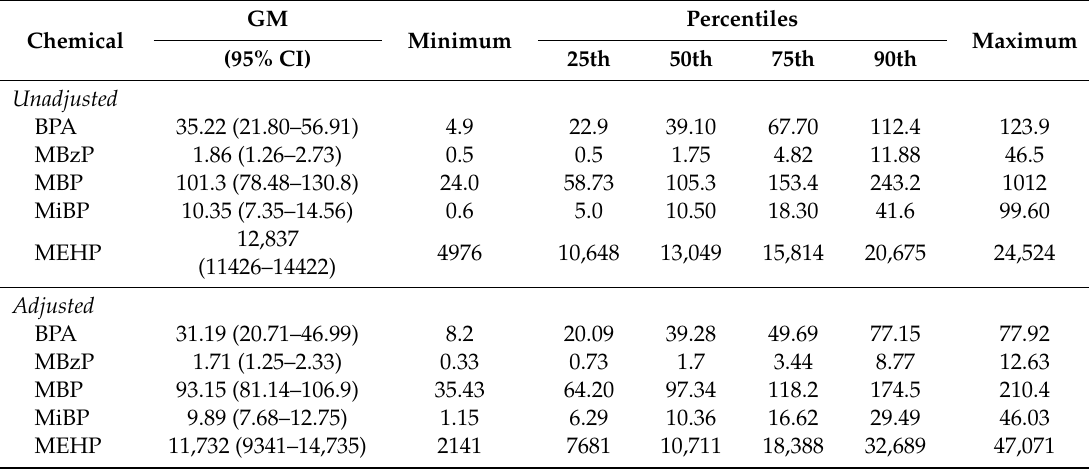
Table 2. Urinary concentrations of unadjusted ( µ g / L) and adjusted total BPA and phthalates metabolites ( µ g / g Cr) for all urine samples.